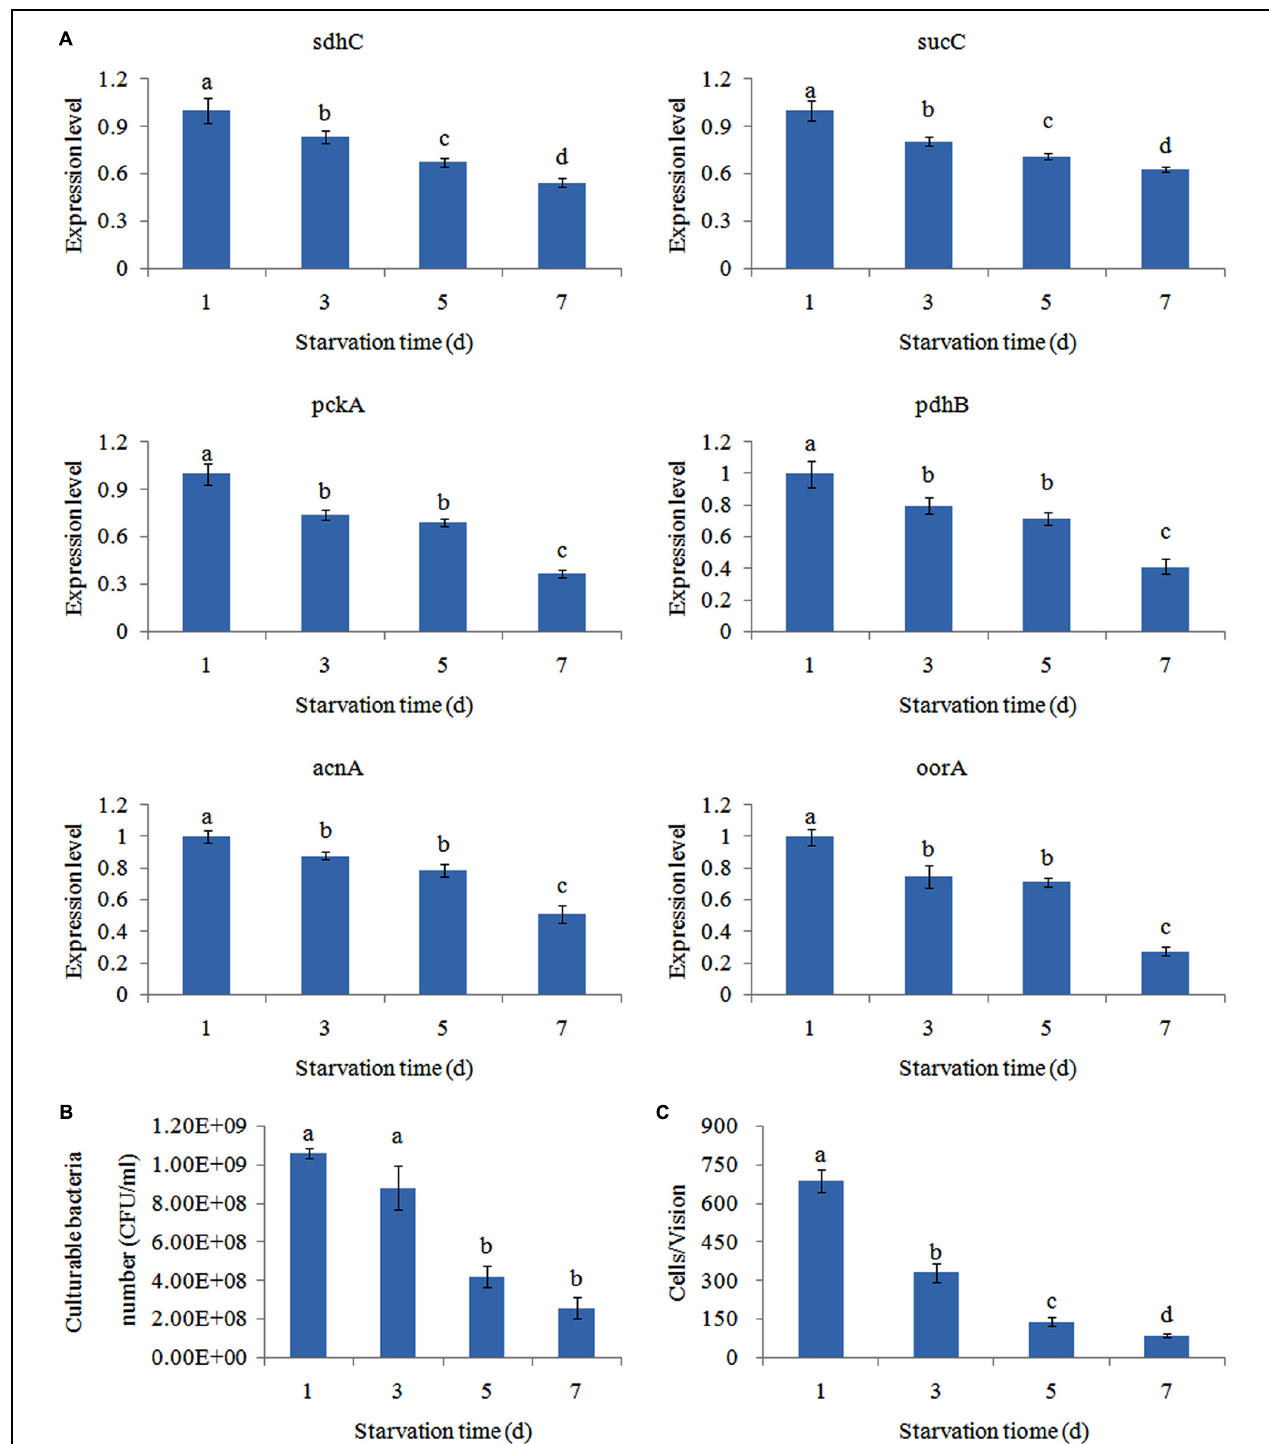
FIGURE 6 | Starvation affected the adhesion of V. alginolyticus . (A) qPCR analysis of the expression of sdhC , sucC , pckA , pdhB , acnA , and oorA after starvation for 1, 3, 5, and 7 days. The data are presented as the means ± SD, n = 6. The means of the treatments not sharing a common letter are significantly different at P < 0.05. (B) Count of culturable bacteria after starvation for 1, 3, 5, and 7 days. The data are presented as the means ± SD, n = 6. The means of the treatments not sharing a common letter are significantly different at P < 0.05. (C) The adhesion capacity to mucus of V. alginolyticus after starvation for 1, 3, 5, and 7 days. The data are presented as the means ± SD, n = 3. The means of the treatments not sharing a common letter are significantly different at P < 0.05, as assessed using one-way ANOVA followed by Dunnett’s test.